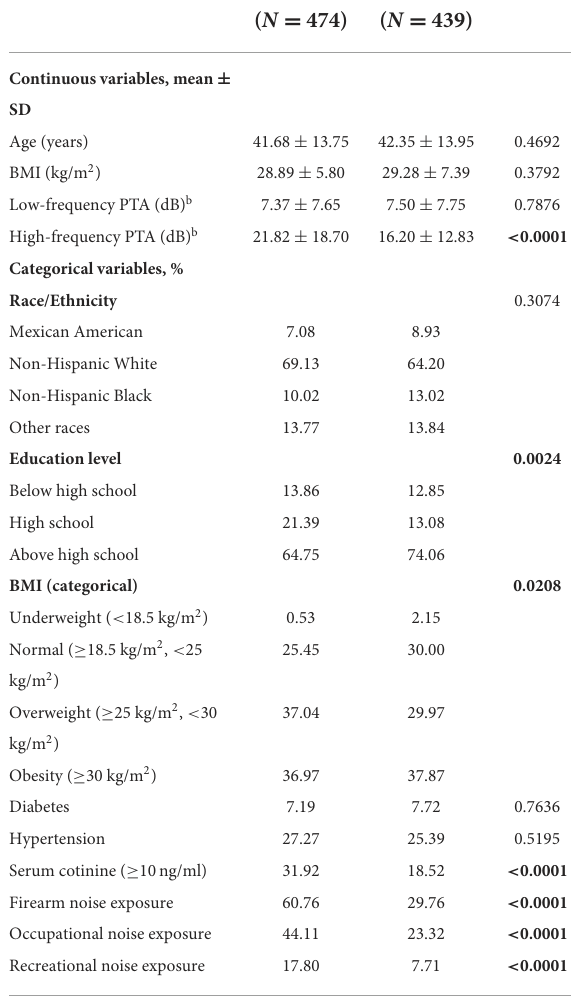
TABLE 1 Weighted demographic characteristics of the study participants.